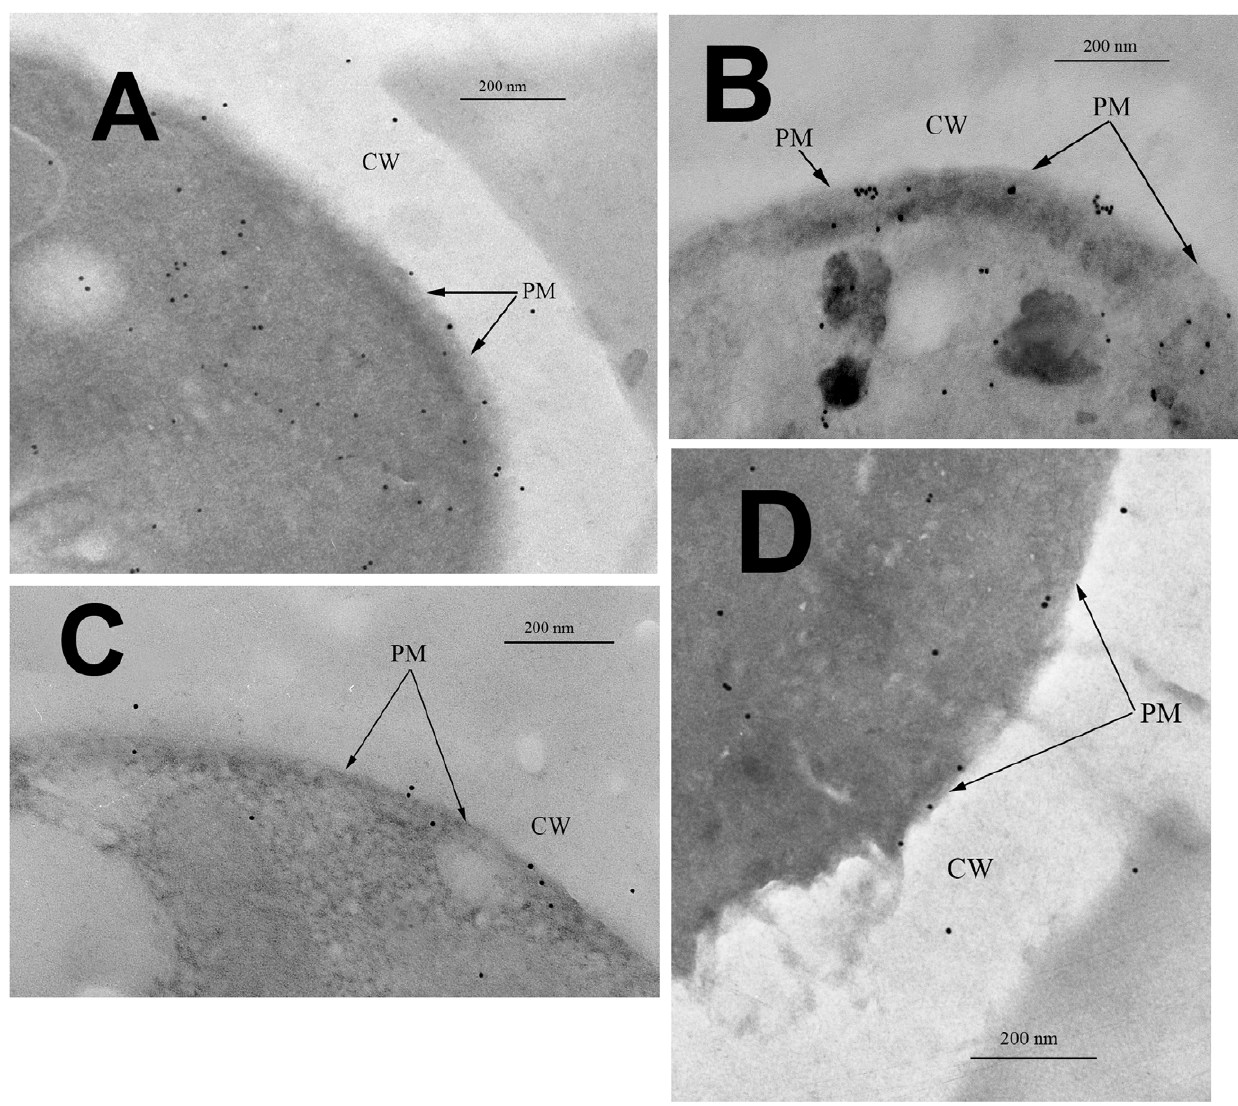
Figure 2. Immunogold labeling of Pma1 in the plasma membrane of S.cerevisiaeerg6 and lcb1-100 . (A) – glucose-starved cells of the erg6 strain, Pma1 was distributed in the membrane as single structures; (B) – erg6 cells that had metabolized glucose for 15 min, Pma1 formed complexes; (C) - glucose-starved cells of the lcb1-100 strain, Pma1 was distributed in the membrane as single structures; (D) – lcb1-100 cells that had metabolized glucose for 15 min, Pma1 was distributed in the membrane as single structures. CW=cell wall; PM=plasma membrane.